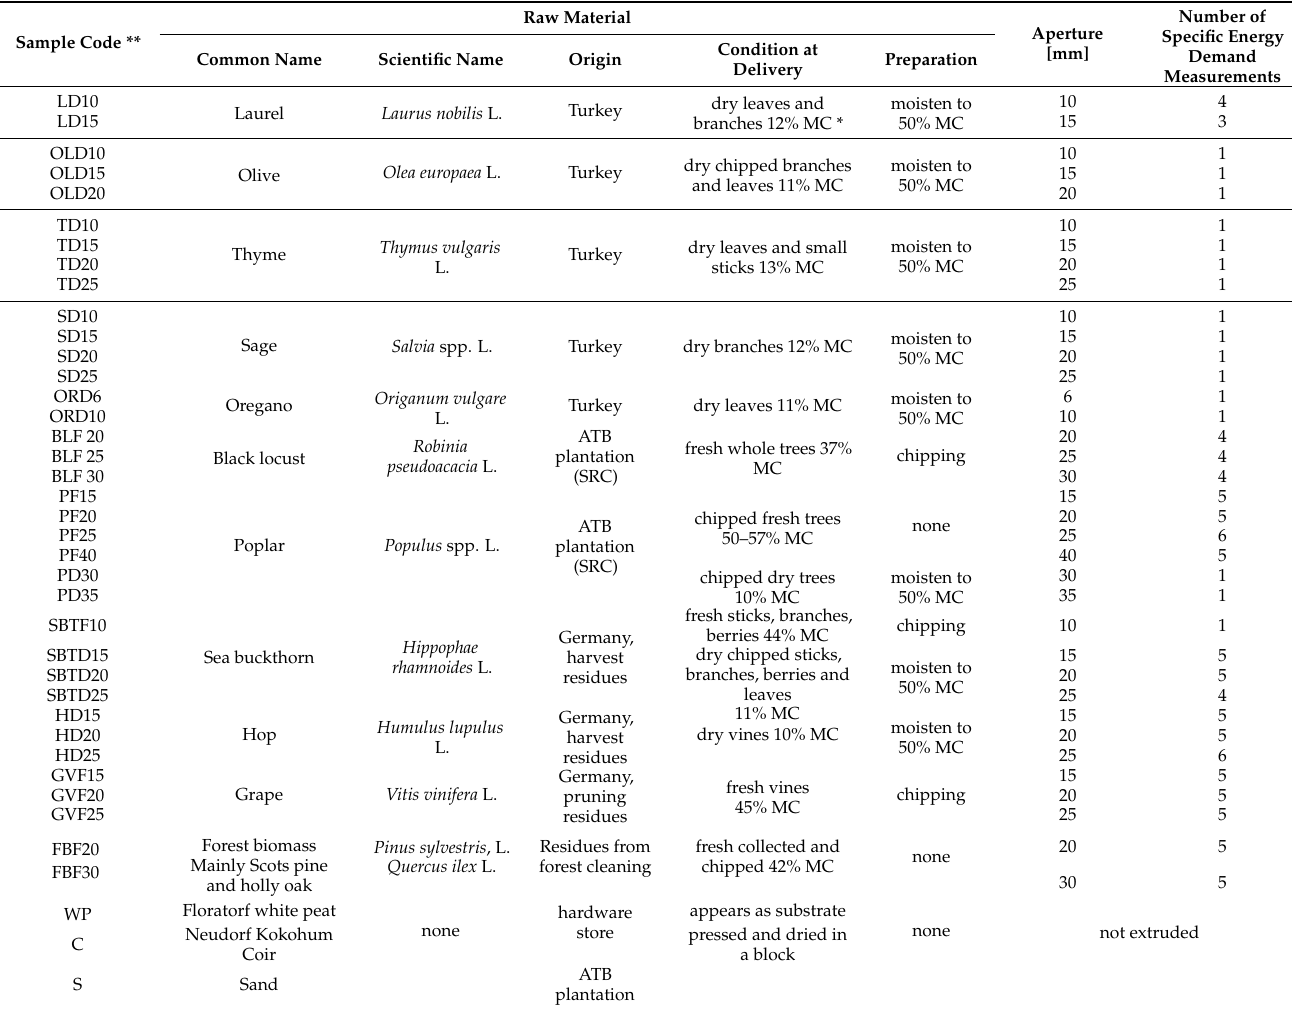
Table 1. Raw material, origin and condition of samples, aperture setting and number of measurements for specific energy demand (dependent on